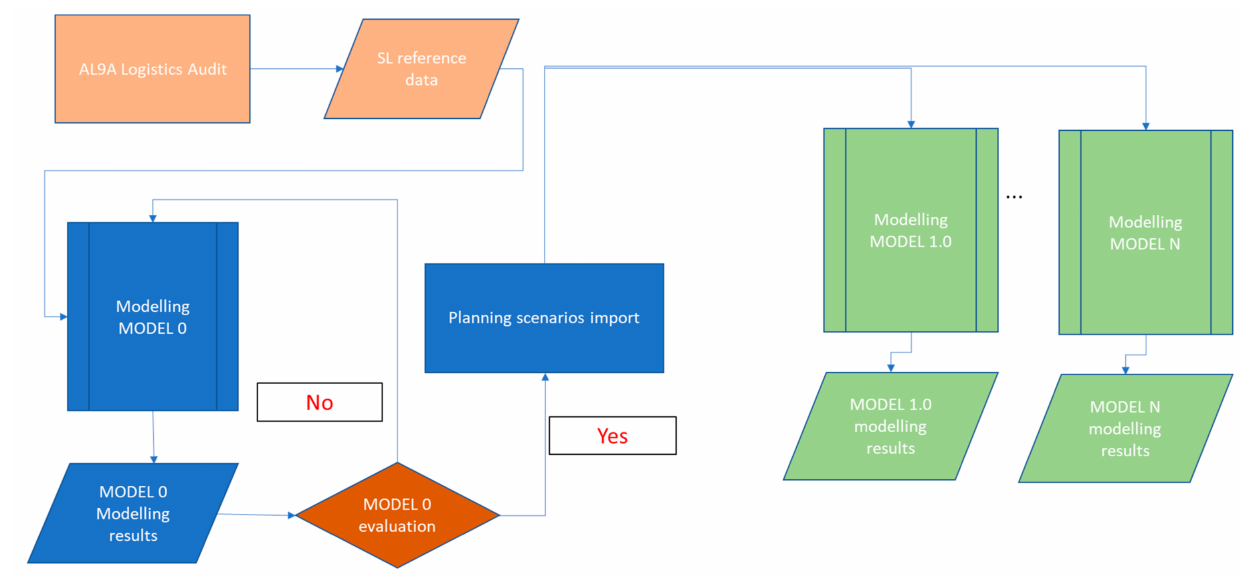
Figure 5. The PL9A planning process.